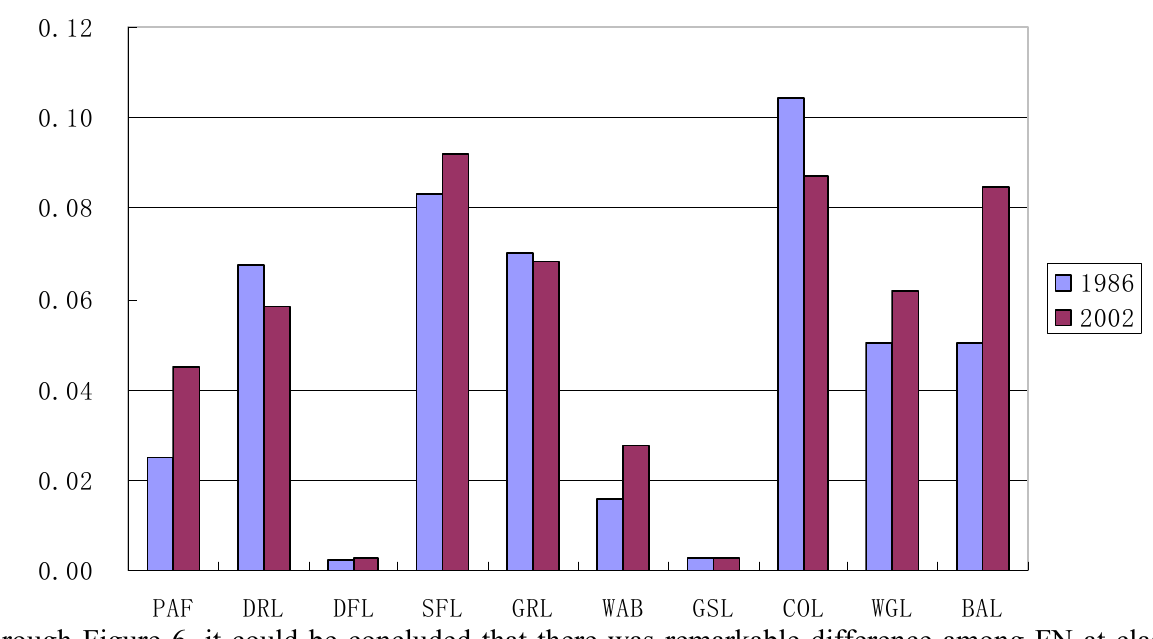
Figure 6. Change of FN at class level in Lijiang County during